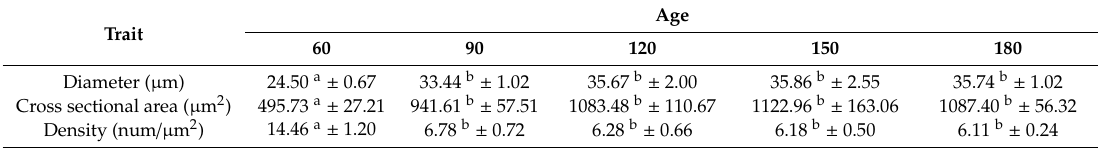
Table 4. E ff ect of age on myofiber characteristics of Da-Heng meat type birds.